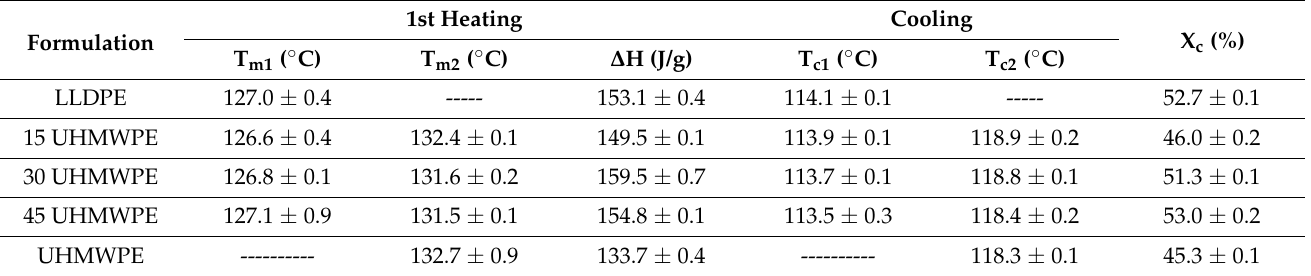
Table 2. Thermal behavior data of LLDPE, UHMWPE, and the blends for the second heating.